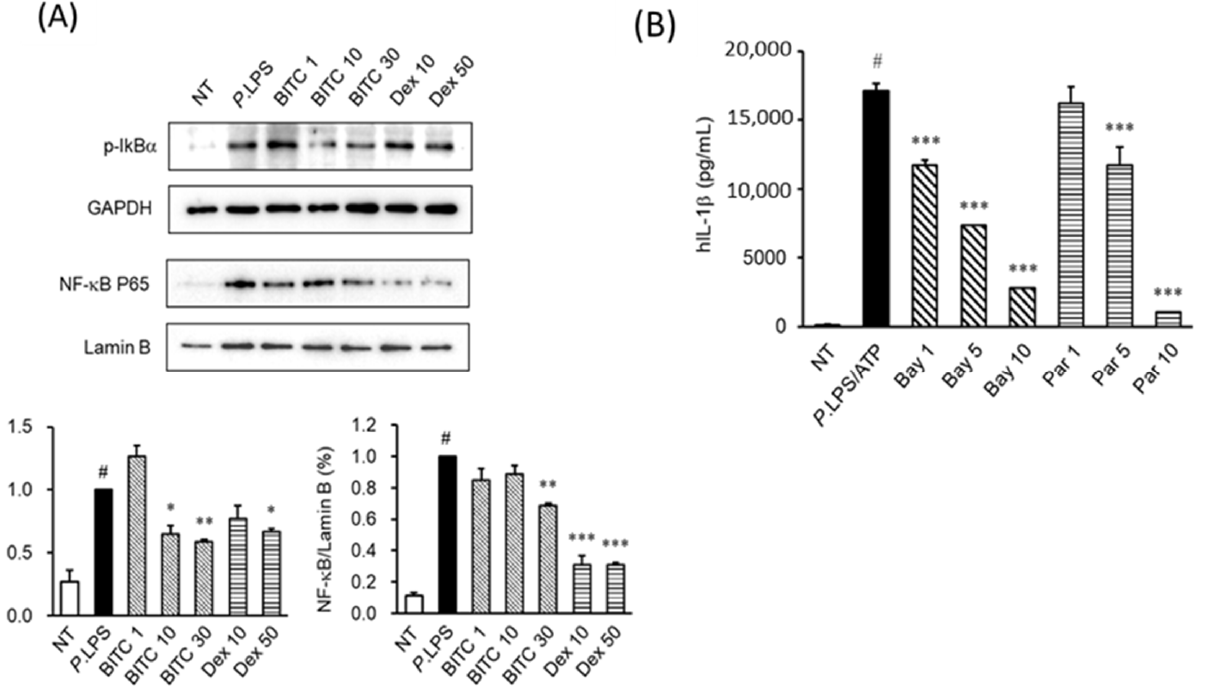
Figure 4. The effect of BITC on NF- κ B activation in P. aeruginosa LPS-stimulated THP-1 cells. ( A ) The cells were pretreated with BITC (1, 10, and 30 μ M) for 1 h and then stimulated with P. aeruginosa LPS for 1 h. Cytosol protein extracts were prepared as described in the materials and methods and evaluated for phosphorylation of IkB α using western blot analyses. Nuclear protein extracts were prepared and analyzed for NF- κ B nuclear translocation using western blot analyses. ( B ) After stim- ulation with P. aeruginosa LPS/ATP for 24 h in the presence or absence of Bay 11-7082 (1, 5, and 10 μ M) and parthenolide (1, 5, and 10 μ M) for 1 h, IL-1 β production by THP-1 cells was determined via ELISA. ( C ) After treatment with LPS/ATP in the presence or absence of Bay 11-7082 and par- thenolide for 1 h, NLRP3 (LPS for 3 h) and caspase-1 (LPS for 1 h) protein expression were deter- mined using western blotting. GAPDH was used as an internal control for the western blot analyses. Each value indicates the mean ± SD and is representative of results obtained from three independent experiments. # p <0.05 vs. untreated group; * p < 0.05, ** p < 0.01 and *** p < 0.001 vs. P. aeruginosa LPS group. NT, untreated group; Bay, Bay 11-7082; Par, parthenolide.